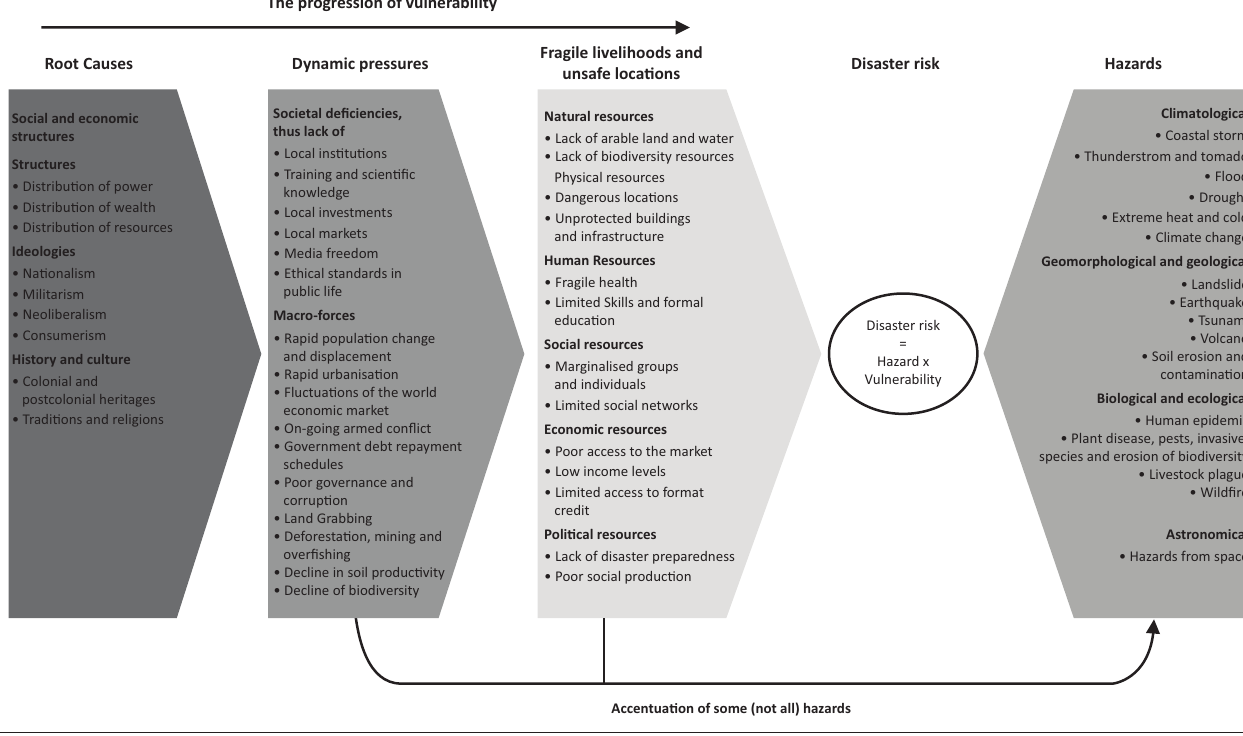
FIGURE 1: The pressure and release